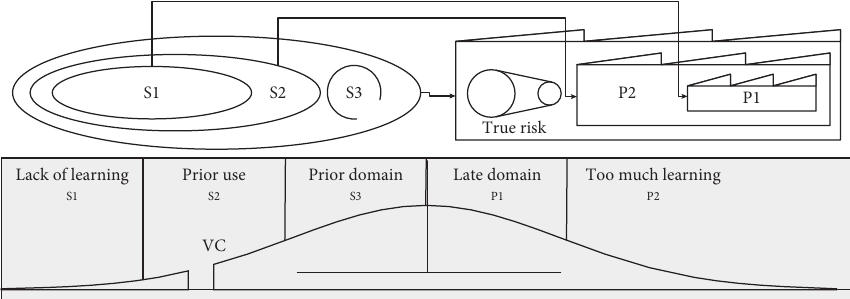
Figure 3: The schematic diagram of structural risk minimization.